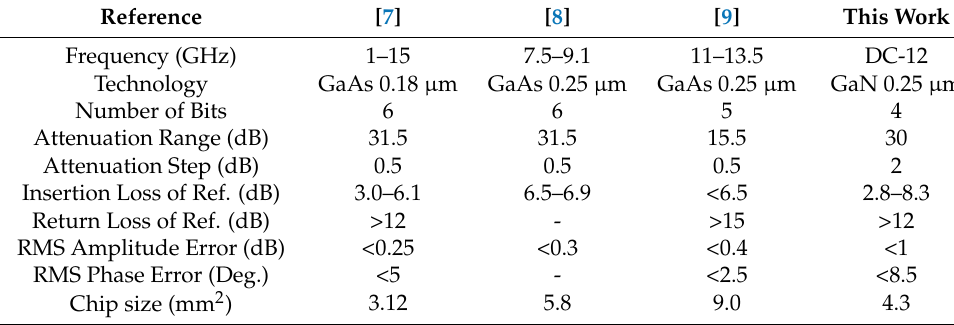
Table 2. Performance comparison of the relevant digital control step